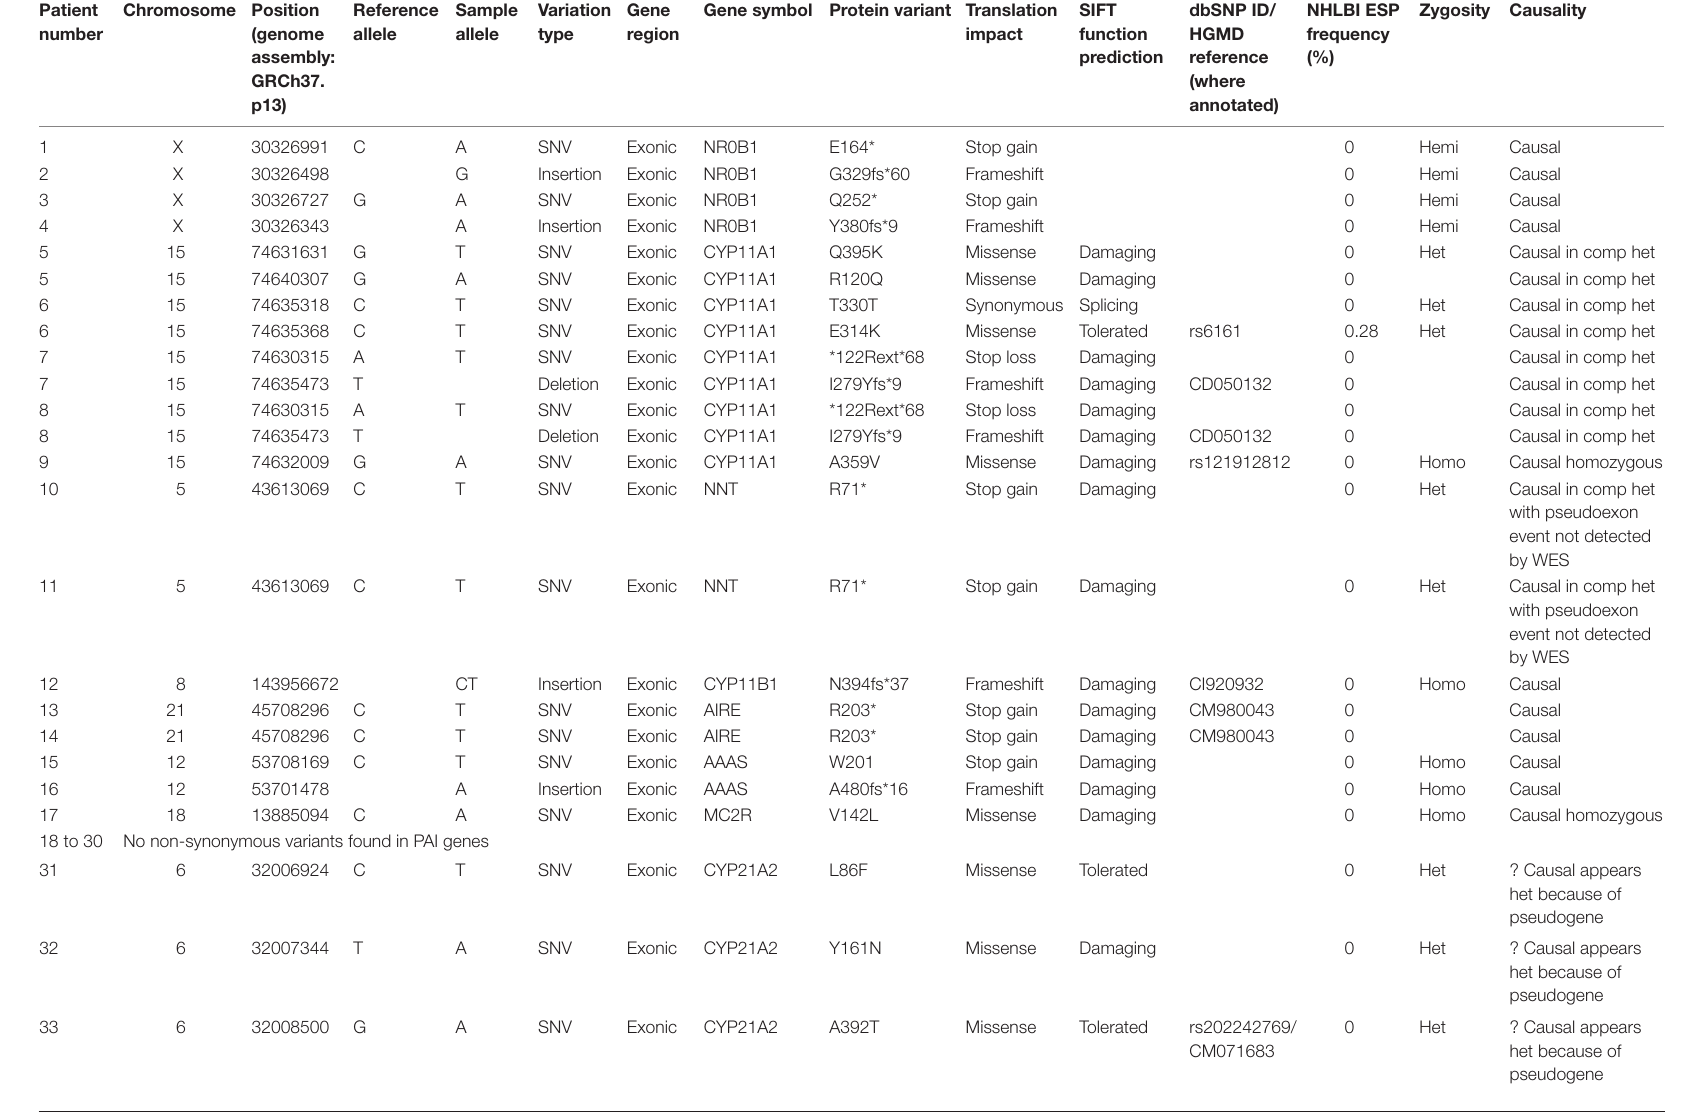
TaBle 2 | non-synonymous variants detected after ingenuity filtration screening of the 20 Pai causal genes listed in Table 1. Patient chromosome Position number